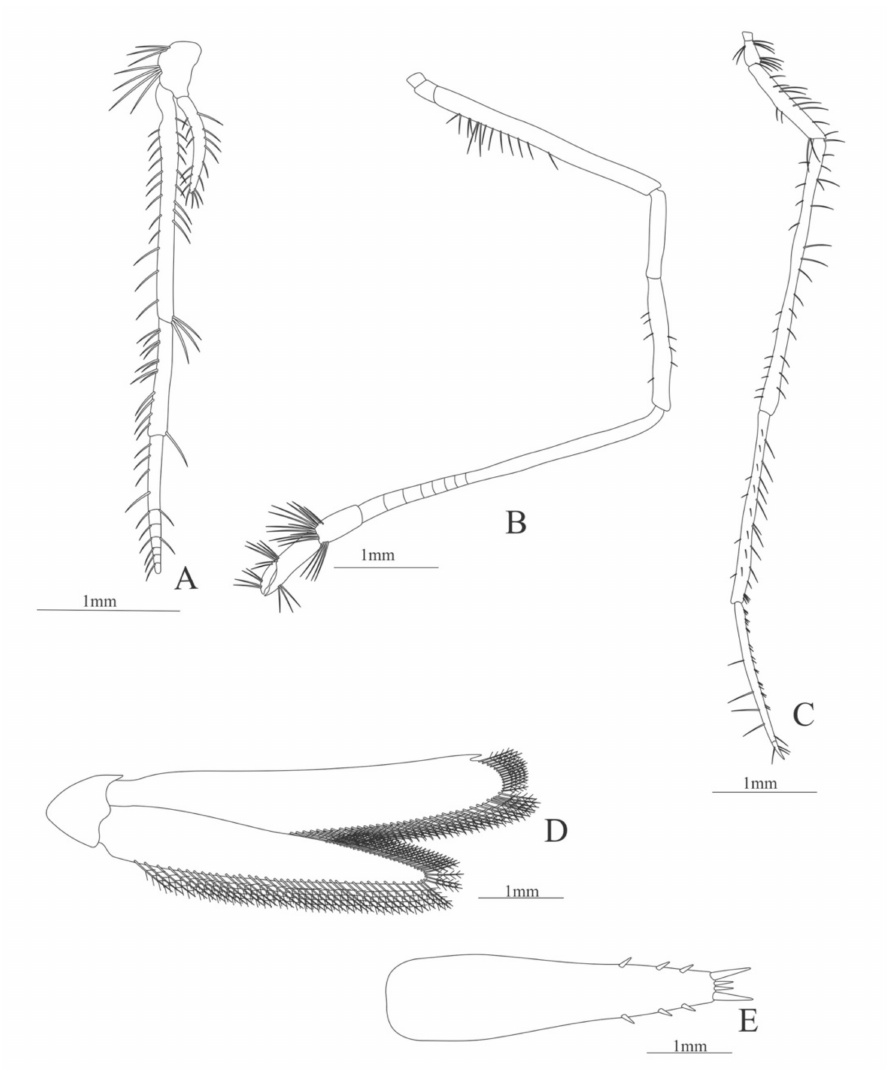
Figure 24. Plesionika ensis : ( A ) third maxilliped; ( B ) second pereopod; ( C ) fifth pereopod; ( D ) Uropods; ( E )